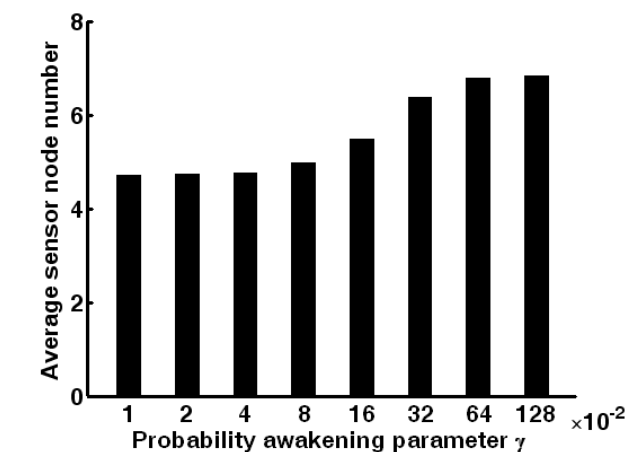
Figure 13. Average number of sensor nodes available for target detection in one sensing period with different probability awakening parameter g